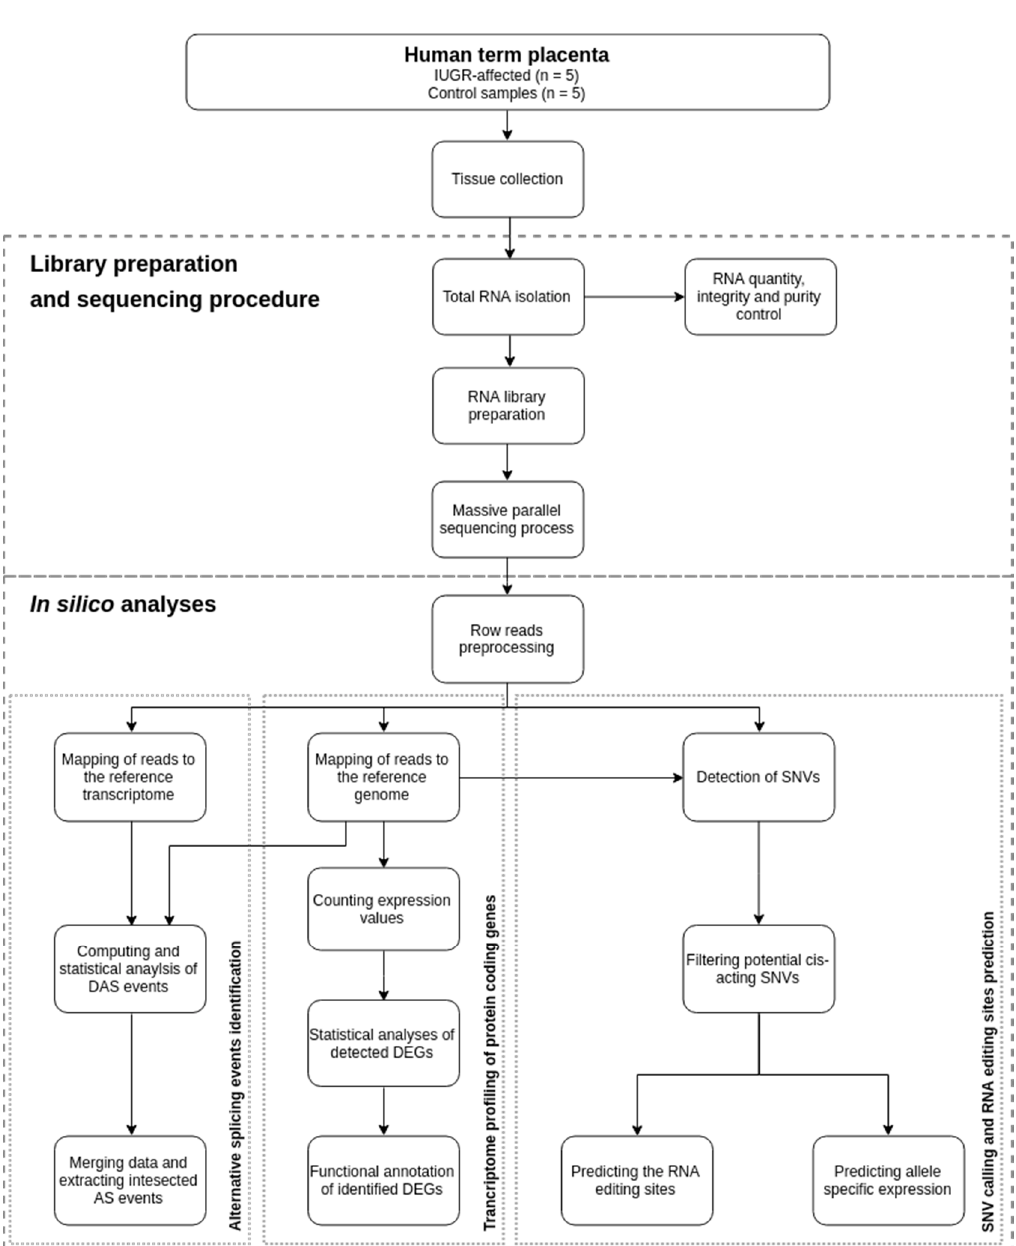
Figure 1. Flowchart of sequencing, computational analysis, and validation procedures.